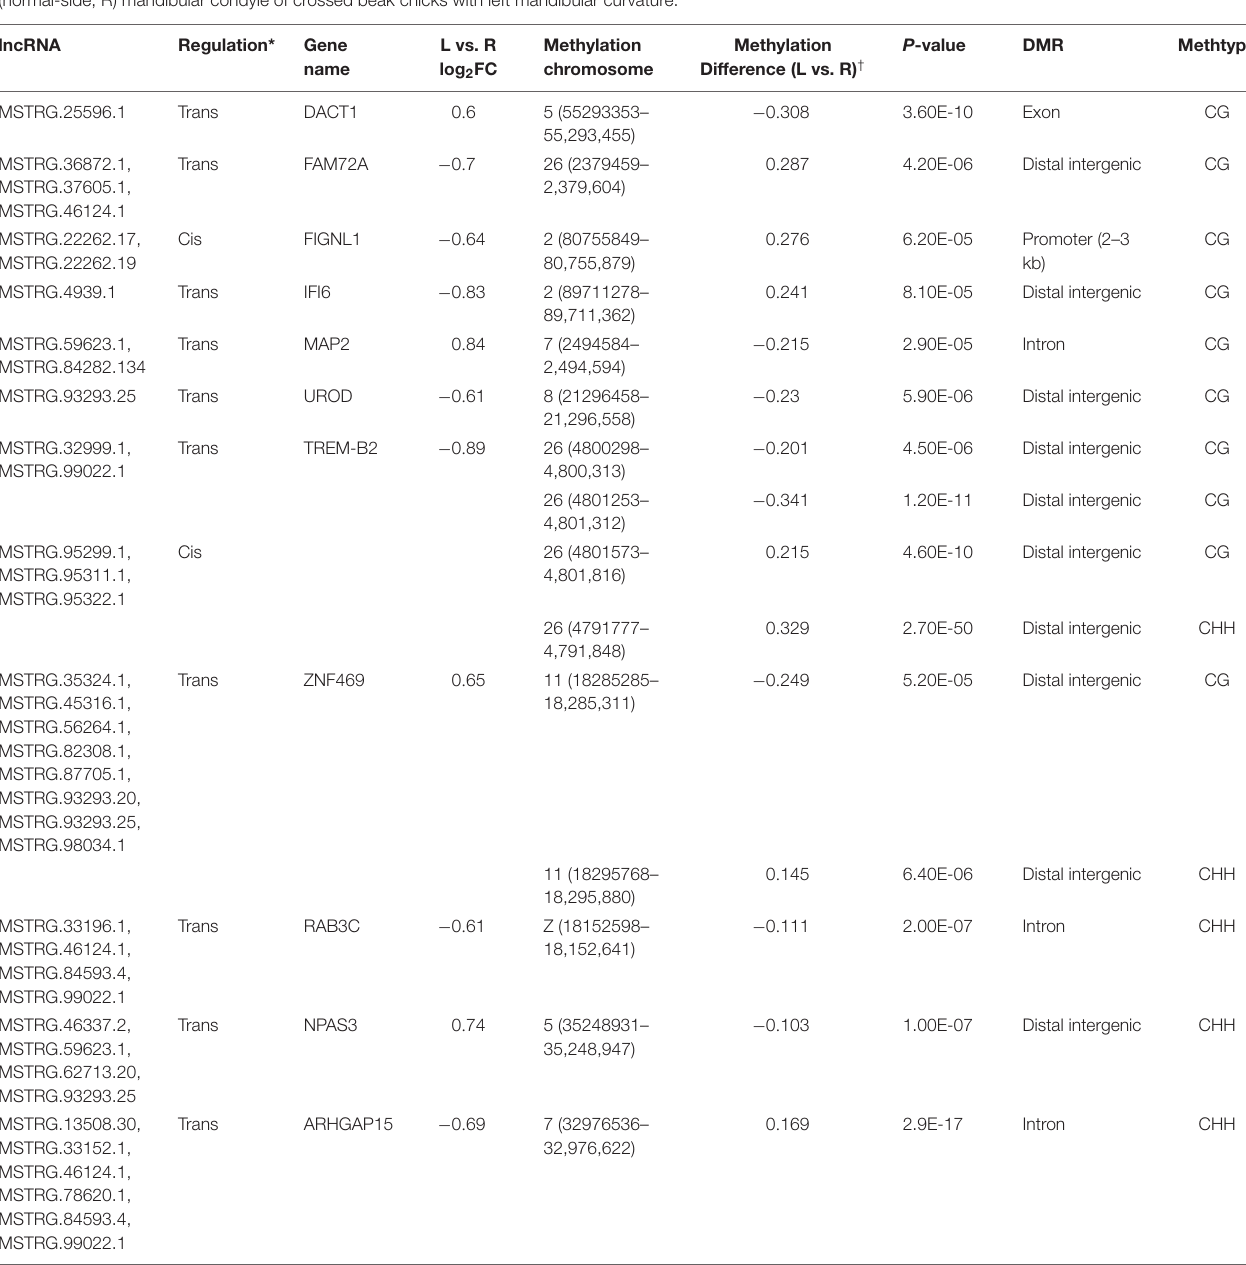
TABLE 2 | The 11 candidate genes regulated by both long non-coding RNA (lncRNA) and DNA methylation in the left-side (affected-side; L) and the right-side (normal-side; R) mandibular condyle of crossed beak chicks with left mandibular curvature.